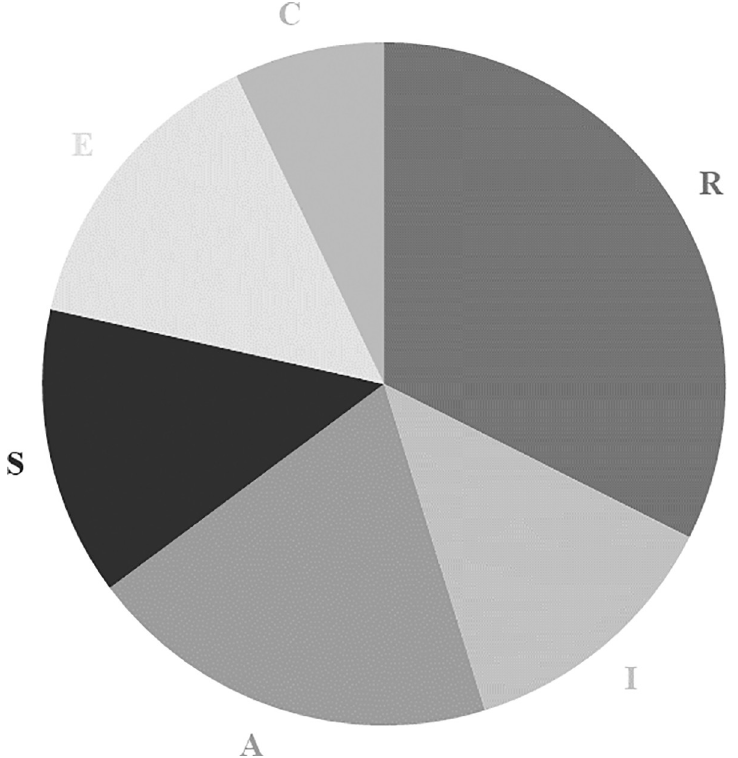
Fig 4. Distribution of one-dimensional interest types among young